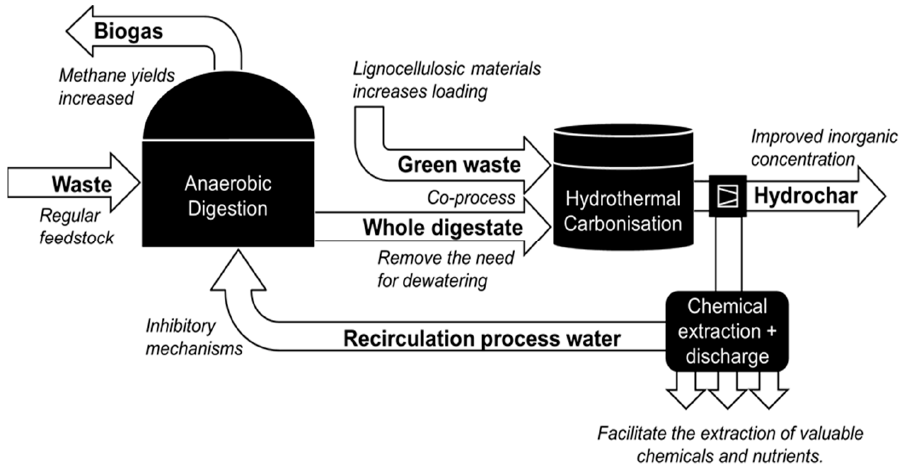
Figure 1. Schematic of a possible HTC/AD integration strategy for the treatment of